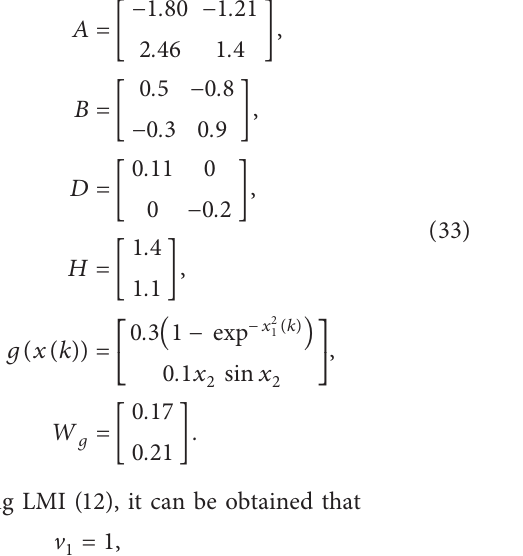
Figure 1: The overall fault diagnosis and fault-tolerant control diagram. The probability of missing measurements is 0.3